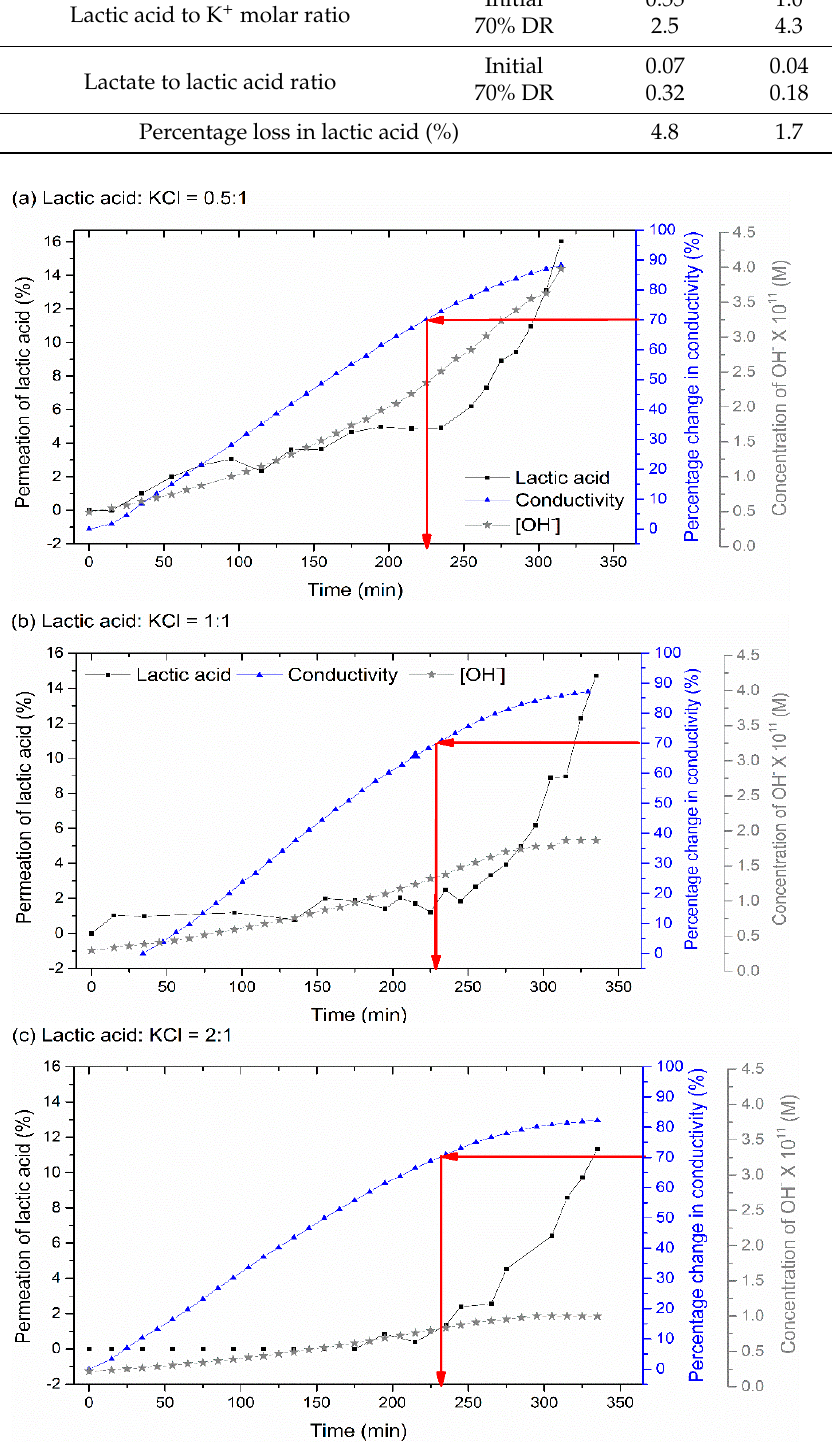
Figure 10. The percentage removal of lactic acid ( ⯀ ) and salt (as given by the conductivity, ( ▲ )) from the diluate with time for three different feed compositions ( a ) Lactic acid:KCl = 0.5:1, ( b ) Lactic acid:KCl = 1:1 and ( c ) ) Lactic acid:KCl = 2:1, treated at a constant voltage of 2.4 V. The red arrows indicate the point corresponding to 70% demineralization, as measured by the diluate conductivity. Also shown is the hydroxide (OH − ) concentration in the diluate over this period ( (cid:70)